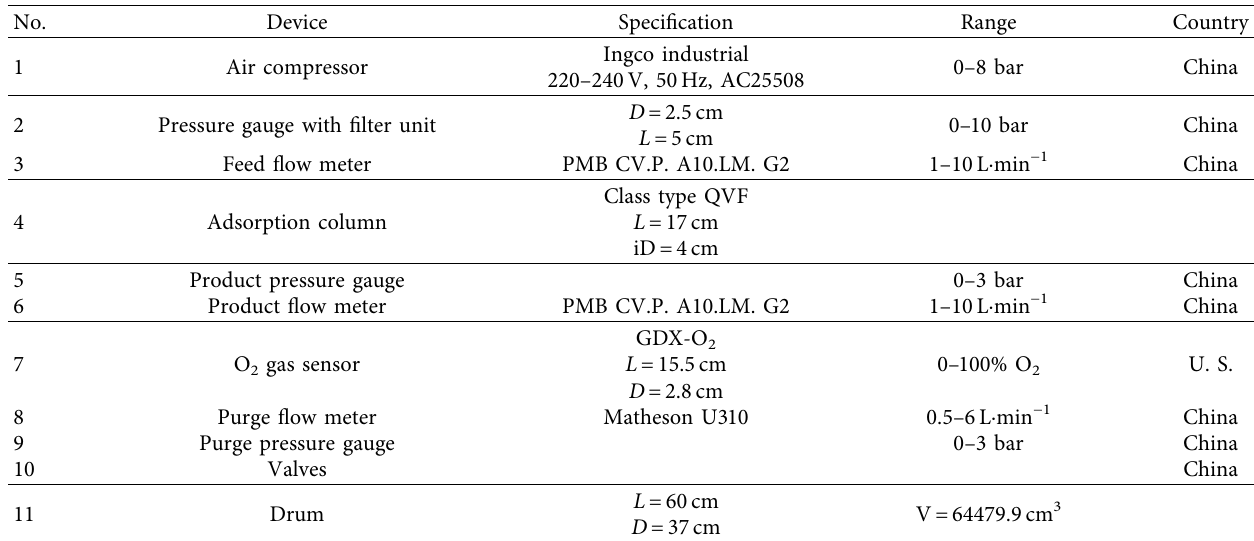
Table 2: Equipment used in the research.